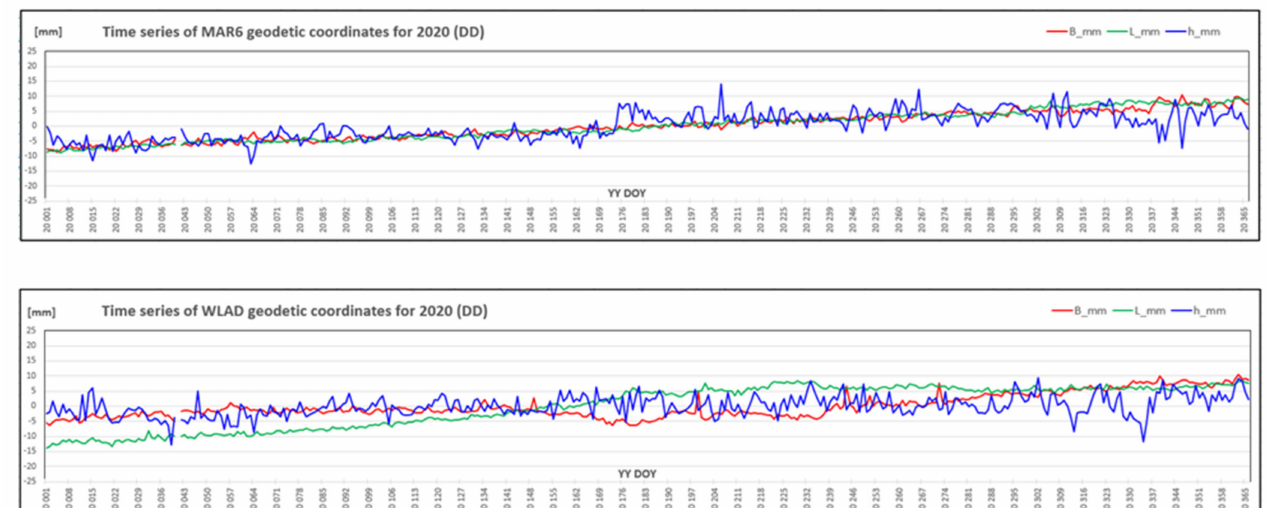
Figure 10. Residual daily coordinate time series with respect to reference coordinates for the year 2020 for Mårtsbo (MAR6, top panel) and Władysławowo (WLAD, bottom panel) permanent GNSS stations. Ellipsoidal latitude is shown in red, longitude in green, and height in blue color. Vertical axis shows coordinate residuals in the range ± 25 mm, horizontal axis specifies the day of year 2020 from day 001 to day